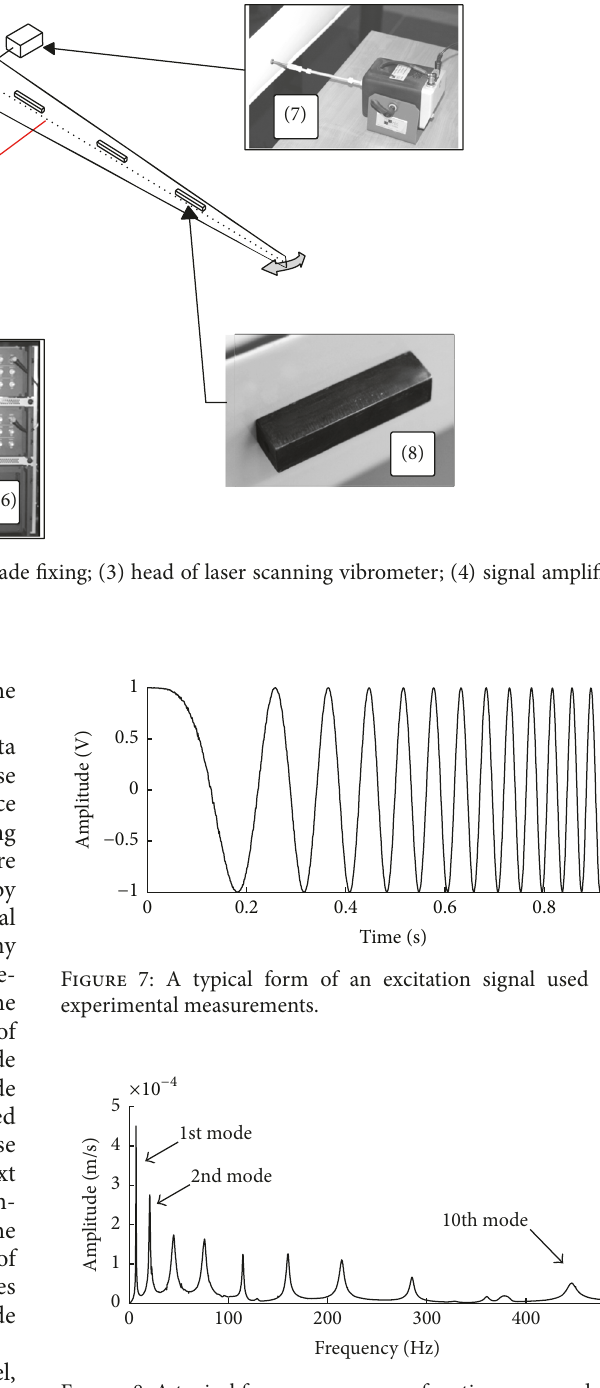
Figure 8: A typical frequency response function measured experi-